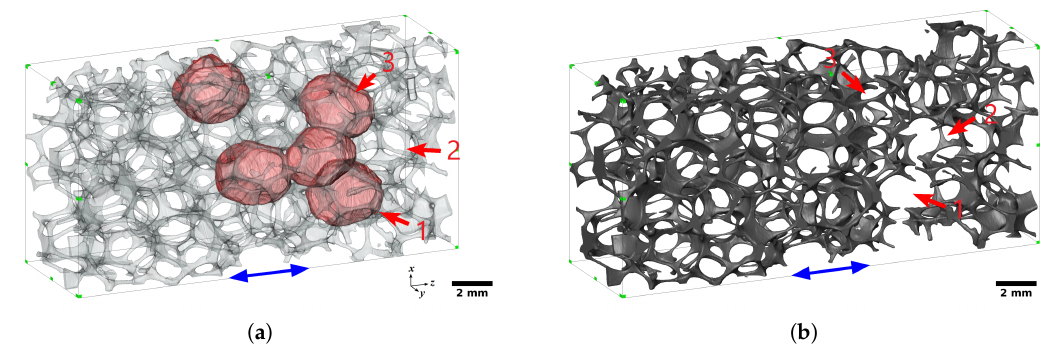
Figure 9. ( a ) The five biggest void-cells and ( b ) the final fractured state of the 20 PPI foam sample. The blue arrow indicates the loading direction. Cells of interest are labeled 1 to 3.